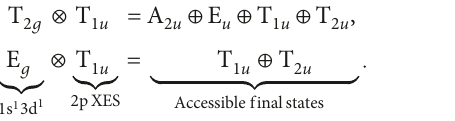
and E due to the 2g g